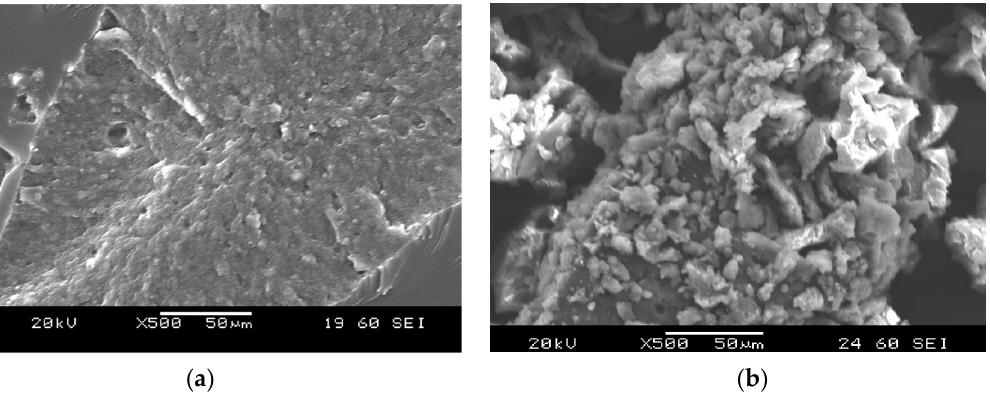
Figure 1. The surface of rubber particles (RP) prepared using a rotary mill ( a ) and using water jet milling ( b ).